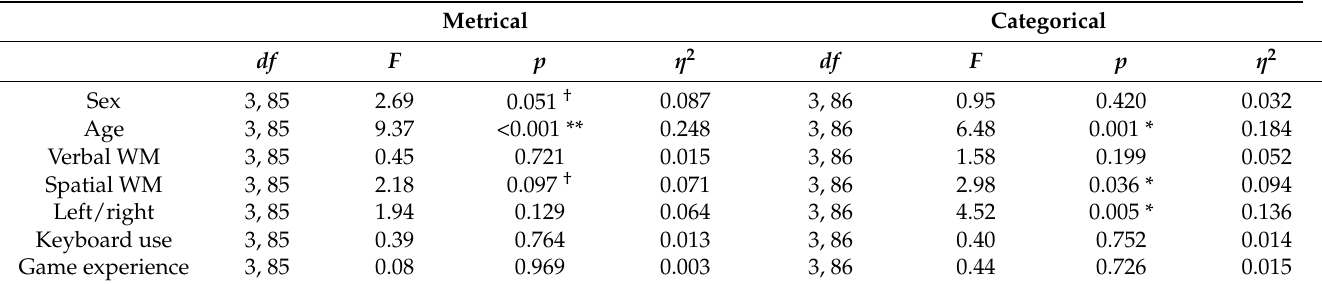
Table 3. MANCOVA analyses on metrical and categorical